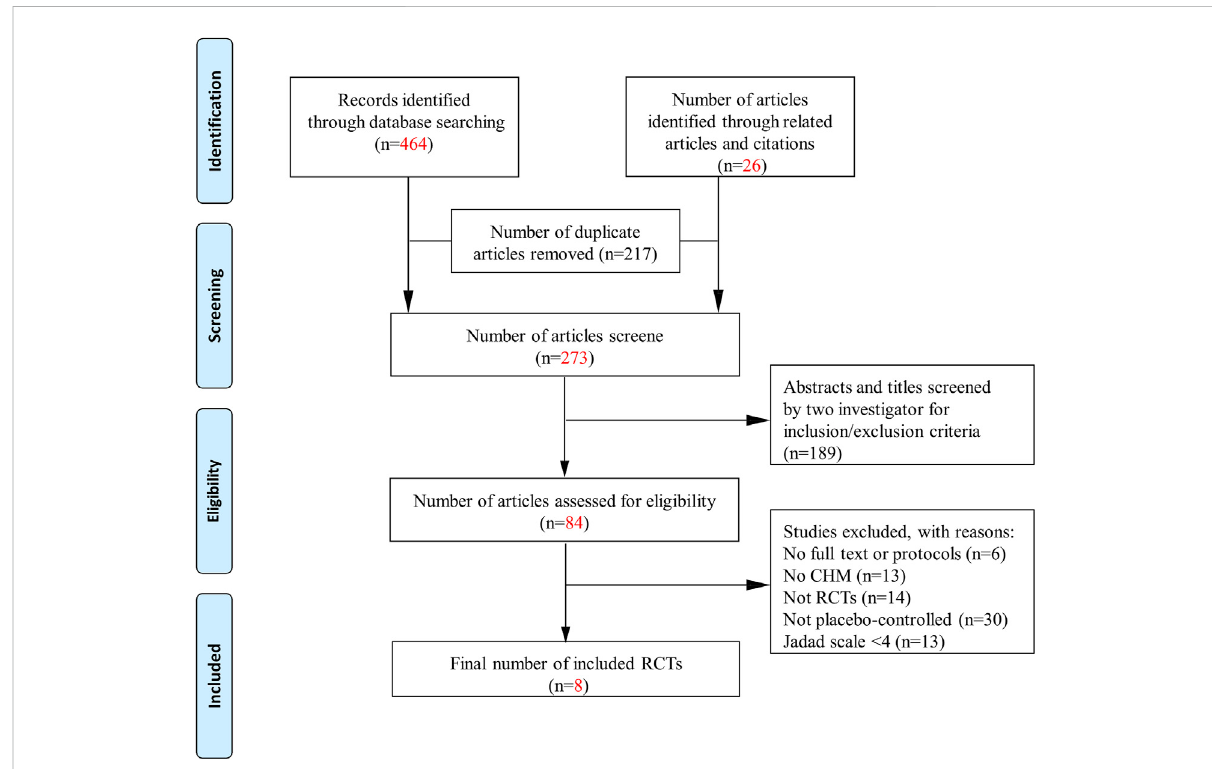
FIGURE 1 Flowchart. CHM, Chinese herbal medicine; RCTs: randomized control trials; AEs, adverse